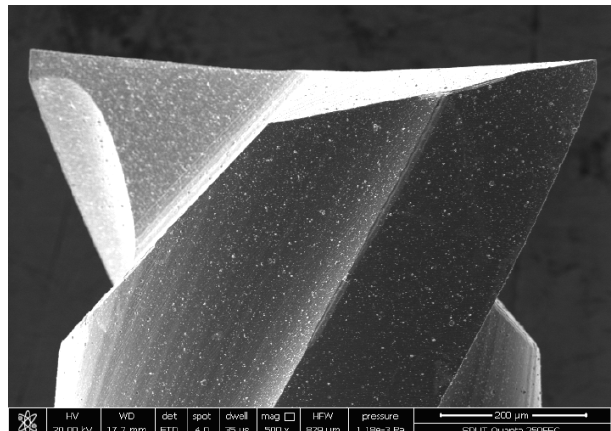
Figure 1. Cutting